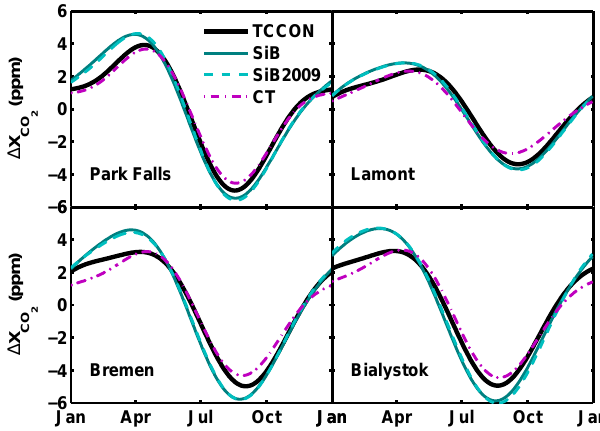
Fig. 3. Detrended seasonal cycles calculated by fitting the data and models (Eq. 2). Model seasonal cycles agree reasonably well with the TCCON data. See Table 3 for the amplitude ratios and time